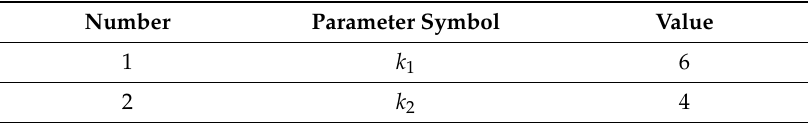
Table 1. Control